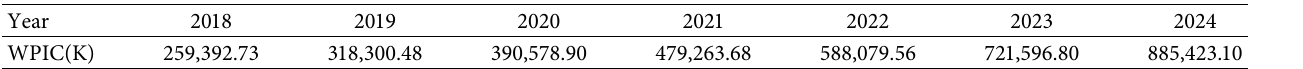
Table 6: Prediction data of WPIC of China during 2018–2024 (ten thousand of